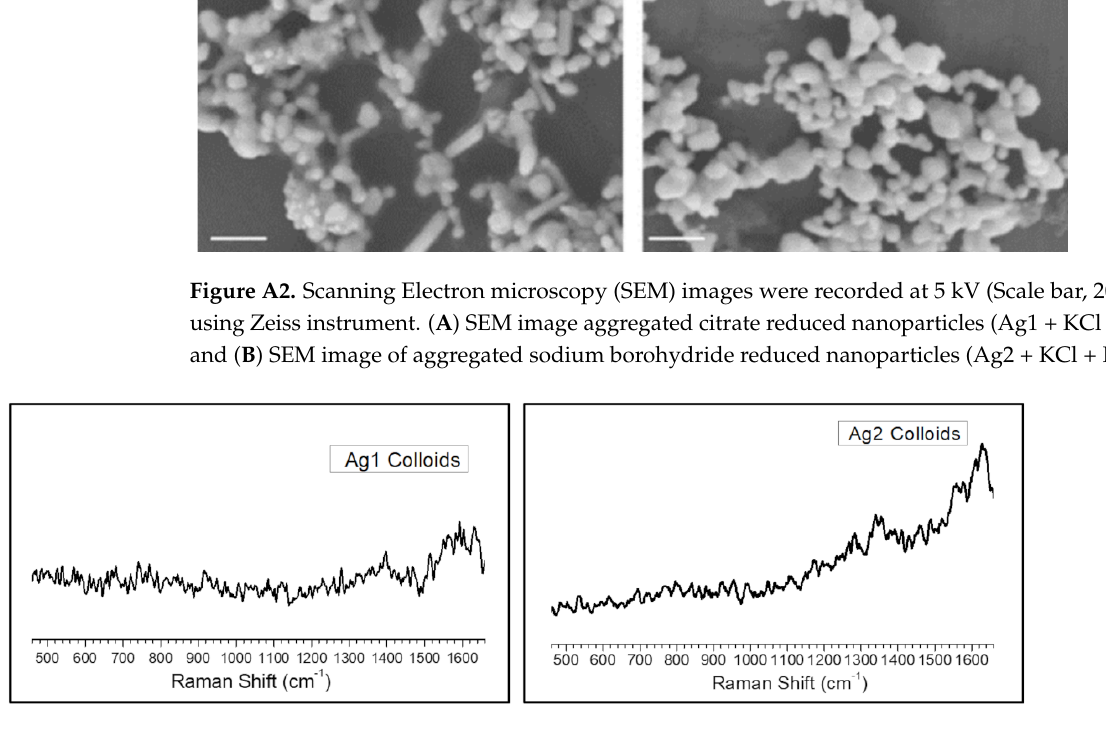
Figure A3. Raman spectra of (left) sodium citrate (Ag1) and (right) sodium borohydride (Ag2) reduced silver nanoparticles.